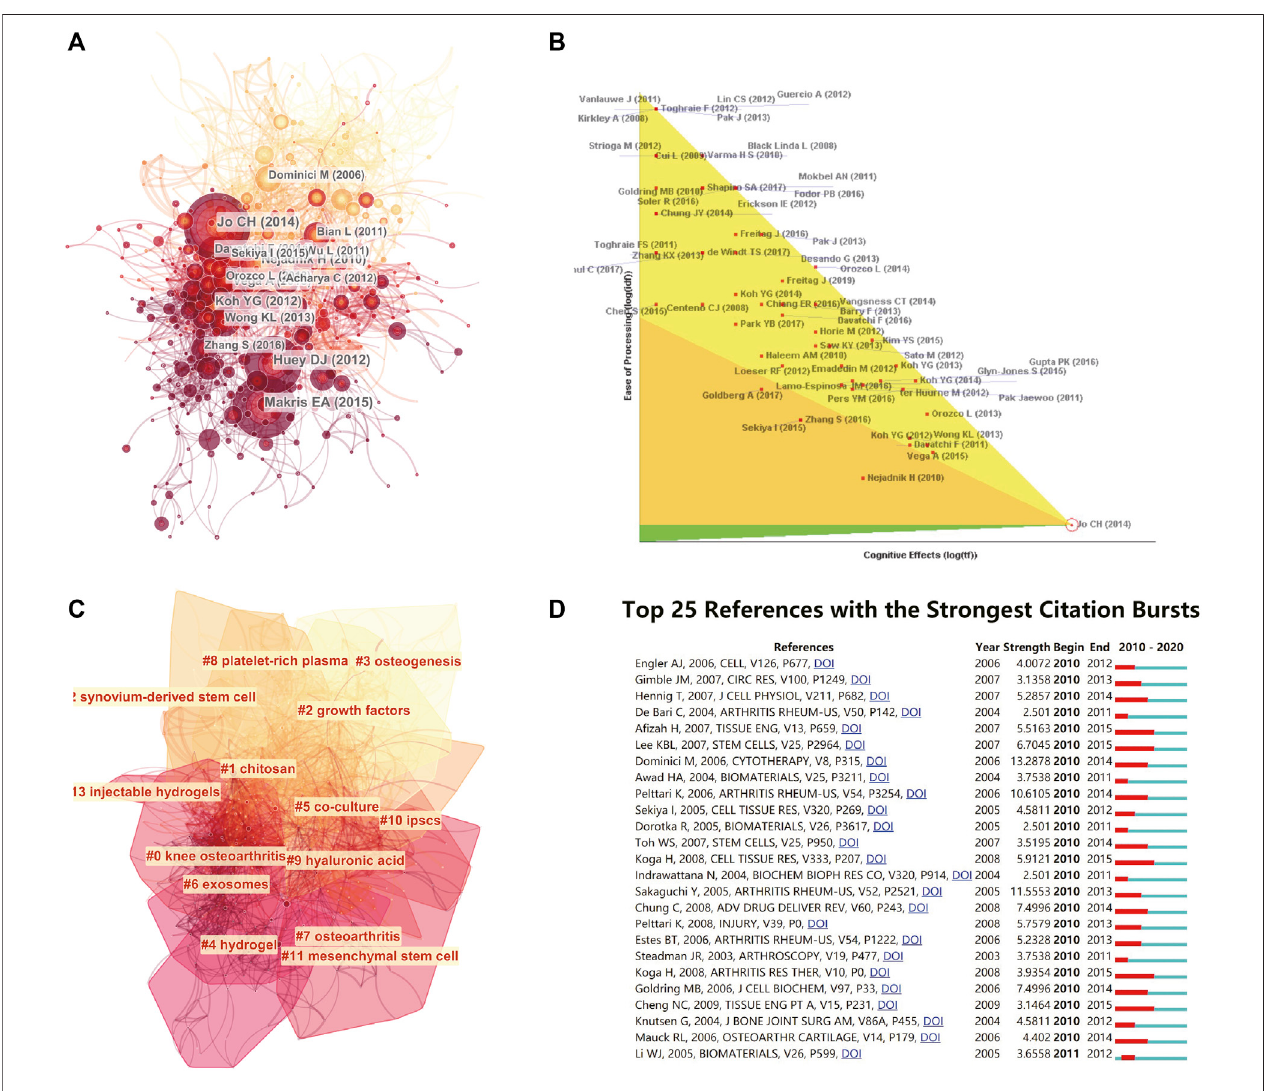
FIGURE5| Mappingofreferencesinstudiesonstemcellsforcartilageregeneration. (A) Asimpli fi edco-citationnetworkofreferencesaboutstemcellsforcartilage regenerationbasedonCiteSpace(burstreferencesarerepresentedbyrednodes). (B) Thearticlewiththehighestcitationratewasalsoprocessed forin-depthanalysis. (C) Clustering analysis of the co-citation network based on CiteSpace. (D) Top 25 references with strongest citation bursts based on CiteSpace.